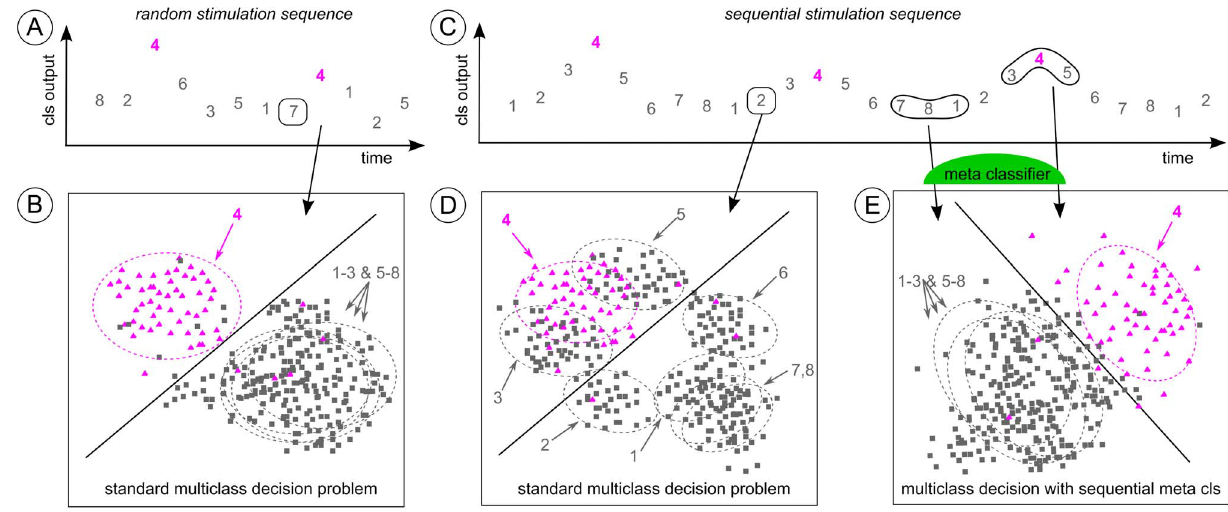
Figure 2. Graphical illustration of the classification problem with sequential stimuli compared to randomly ordered stimuli. The typical oddball scenario with the classification of random stimulation sequences is depicted in plot A and B . For sequential stimuli, it can be observed that classifier outputs of non-targets before or after a target behave similar to target responses (plot C ). This leads to systematic structural distortions in the standard multi-class decision ( D ). Plot E depicts how a meta classifier can make explicit use of the sequential information and thereby improve the multi-class decision. N spatial cls: the standard binary classification procedure was applied to exploit whether the user is attending to the left, middle or right. Thus, a binary classifier was trained for each direction/group. To calibrate each of these classifiers (e.g. for the attended left direction), all stimuli from group L (targets and non-targets) were distributed into class 1 and 2. Those stimuli that were presented while the user was attending to the intended direction (e.g. left) were considered as class 1. All other stimuli which were presented while the user was attending to a different direction were considered as class 2.